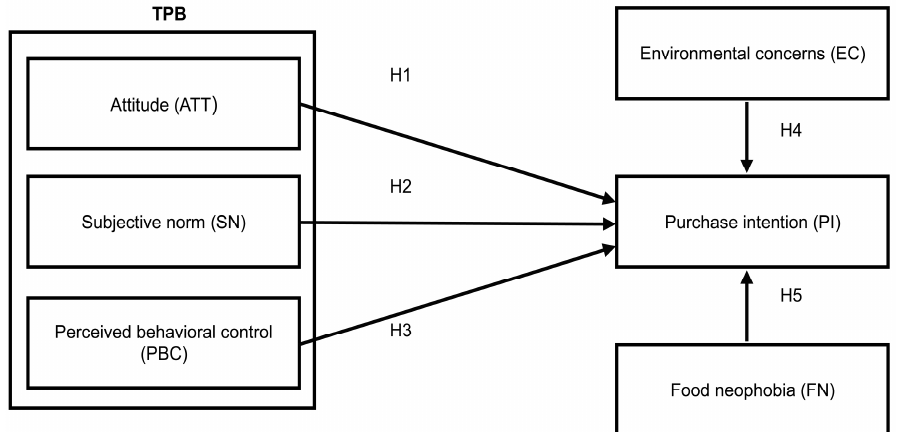
Figure 1. Study hypotheses and conceptual framework. H1, attitude positively affects purchase intention; H2, subjective norms positively affect purchase intention; H3, perceived behavioral control positively affects purchase intention; H4, environmental concern positively affects purchase intention; H5, food neophobia positively affects purchase intention.